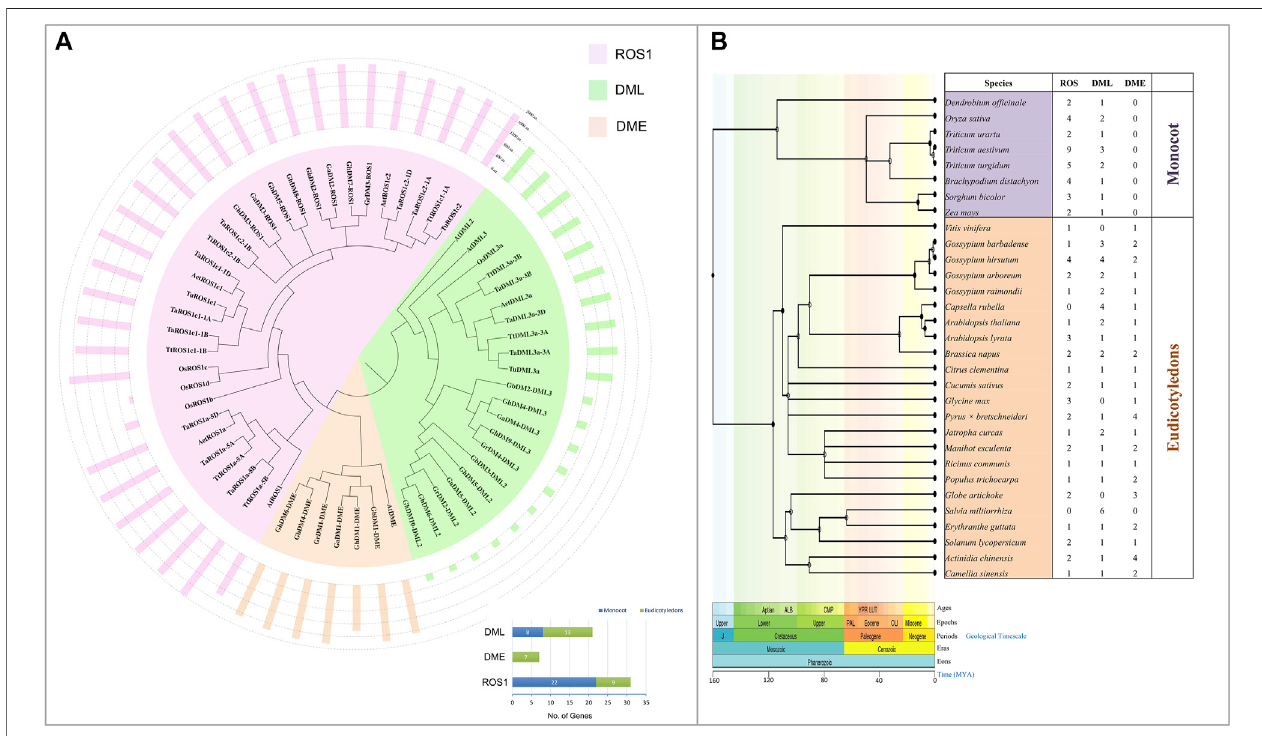
FIGURE1| EvolutionaryrelationshipamongvariousdMTases. (A) Evolutionrelationshipamongthe10plantspecies( Ta , Triticumaestivum ; Aet , Aegilopstauschii ; Tu , TriticumUrartu ; Tt , Triticumturgidum ; At , Arabidopsisthaliana ; Os , Oryzasativa ; Ga , Gossypiumarboretum ; Gb , Gossypiumbarbadense ; Gh , Gossypiumhirsutum ; Gr , Gossypiumraimondii ).Graph(presentatthelowerrightcorner)showsthenumberofdMTasesineachsub-family(ROS1,DML,andDME). (B) Datedphylogenytrees for31plantspeciesbelongingtomonocotandeudicotyledons.Thenumberofgenespresent/absentofROS1,DML,andDMEindifferentplantspeciesisshownin the columns. MYA, a million years ago.